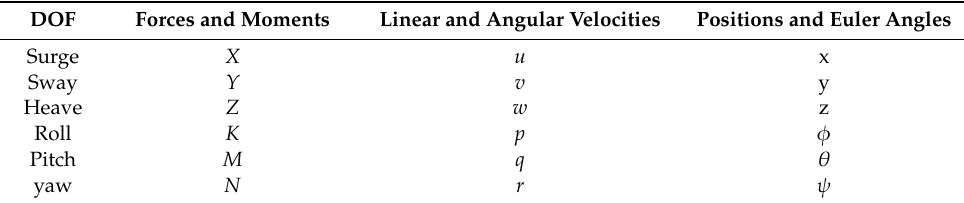
Table 3. The parameters of AUV’s